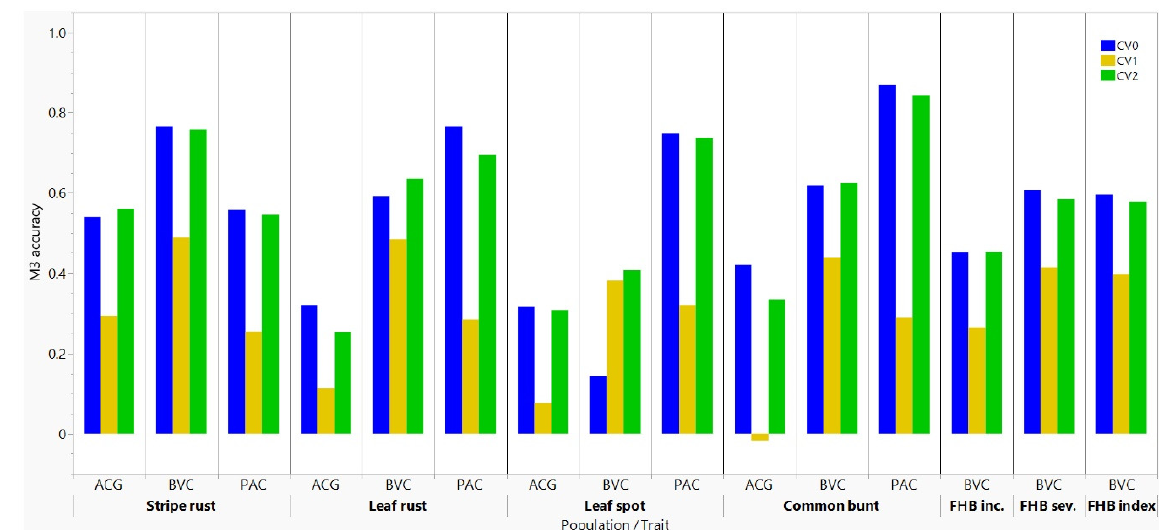
Figure 5. Comparisons of average prediction accuracies using the M3 model with the CV0, CV1, and CV2 random cross-validation schemes that represent predicting the entire environment, the performance of newly developed lines, and sparse testing, respectively. See Table S5 for details.